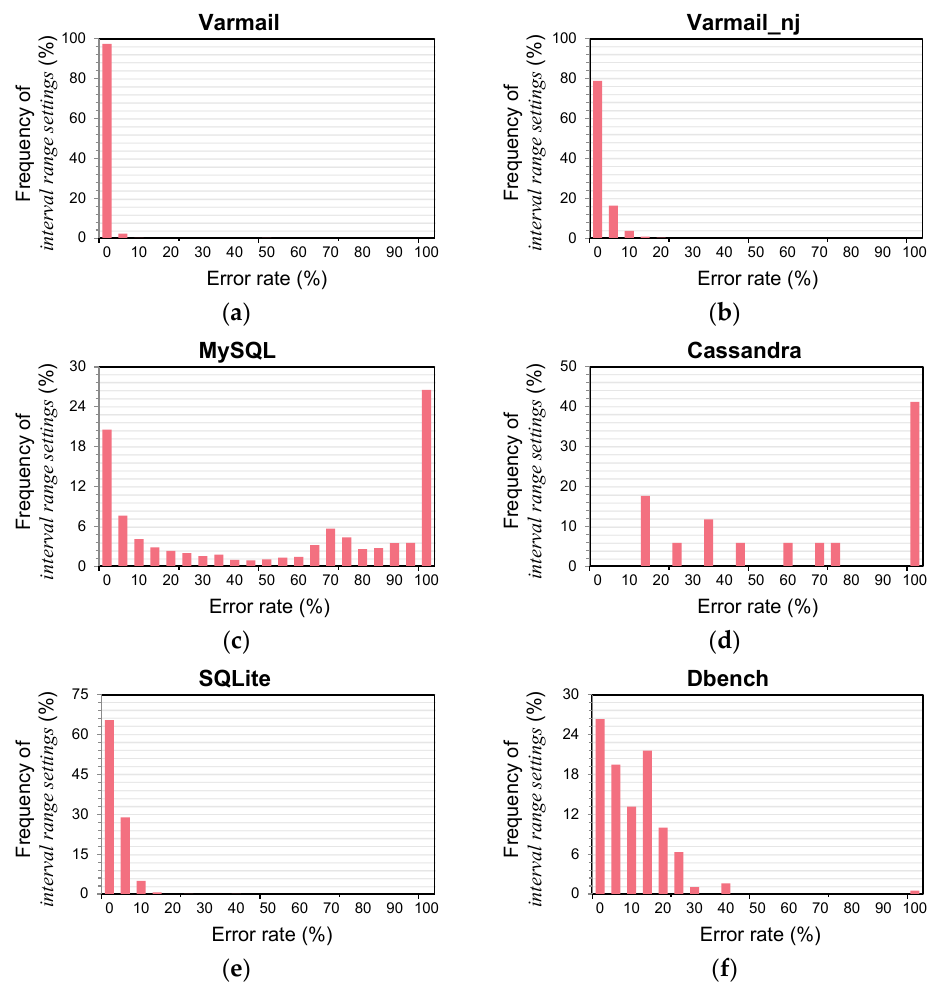
Figure 3. Distributions of error rates associated with mean of intervals in interval range setting.